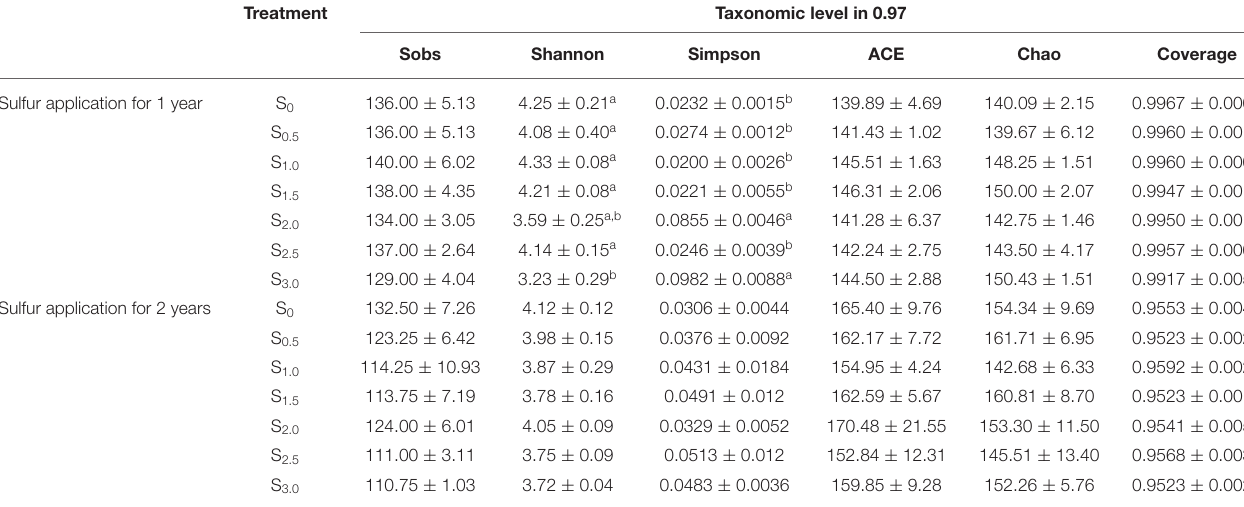
TABLE 3 | Sequence statistics and diversity indexes of sulfur on kiwifruit soil